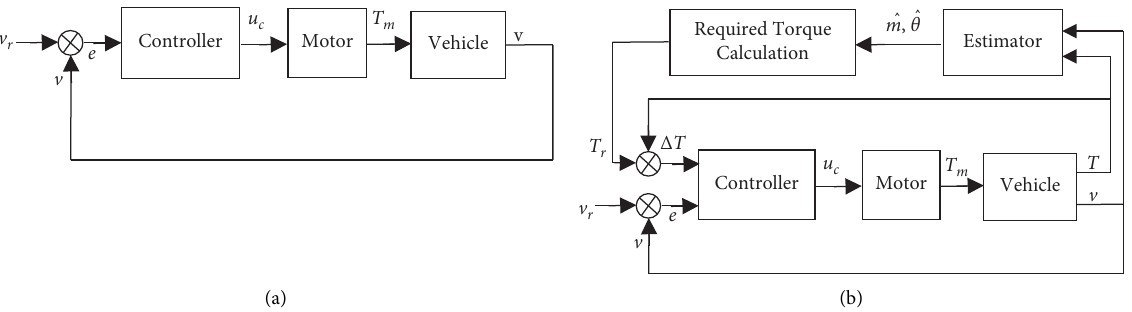
Figure 4: Cruise control scheme. (a) Traditional cruise control scheme. (b) Eco-cruise control